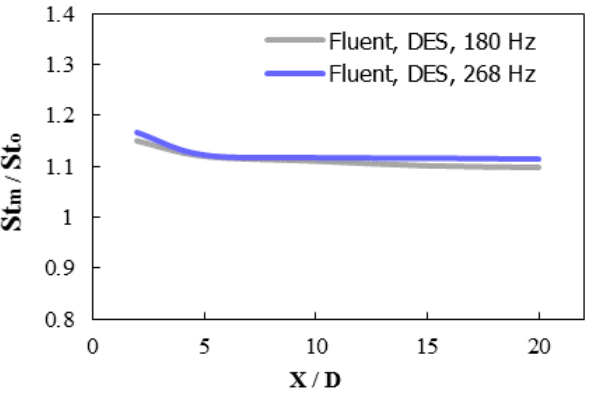
Figure 22. The centerline Stanton number ratio obtained using the DES Realizable k - ε model for M = 0.5 for the 180 and 268 Hz oscillations.